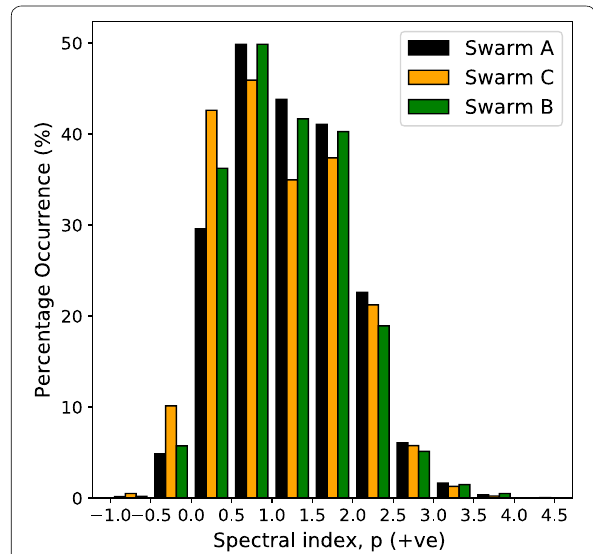
Fig. 10 Percentage occurrence of the spectral indices obtained by a linear fit to the PSD in log–log scale for Swarm A, C, and B for the